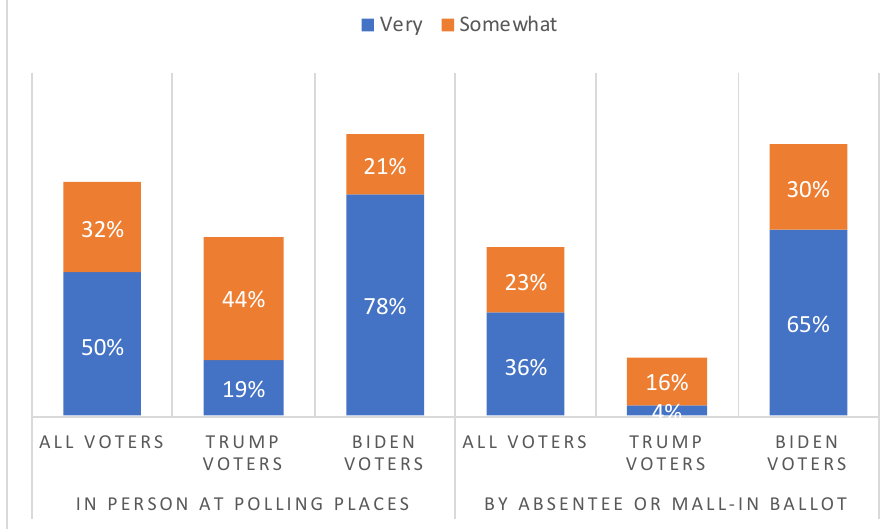
Figure 5. Percentage of voters who are convinced that their vote has been counted correctly. Source: Own elaboration from Pew Research’s American Trend Panel (2020).